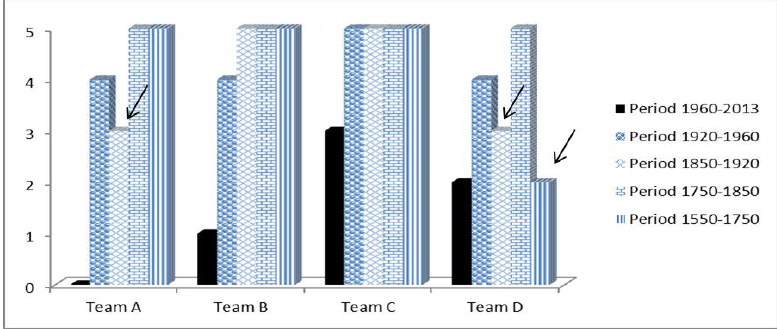
Figure 5 . “Causes” progression of ideas in each team for each period.